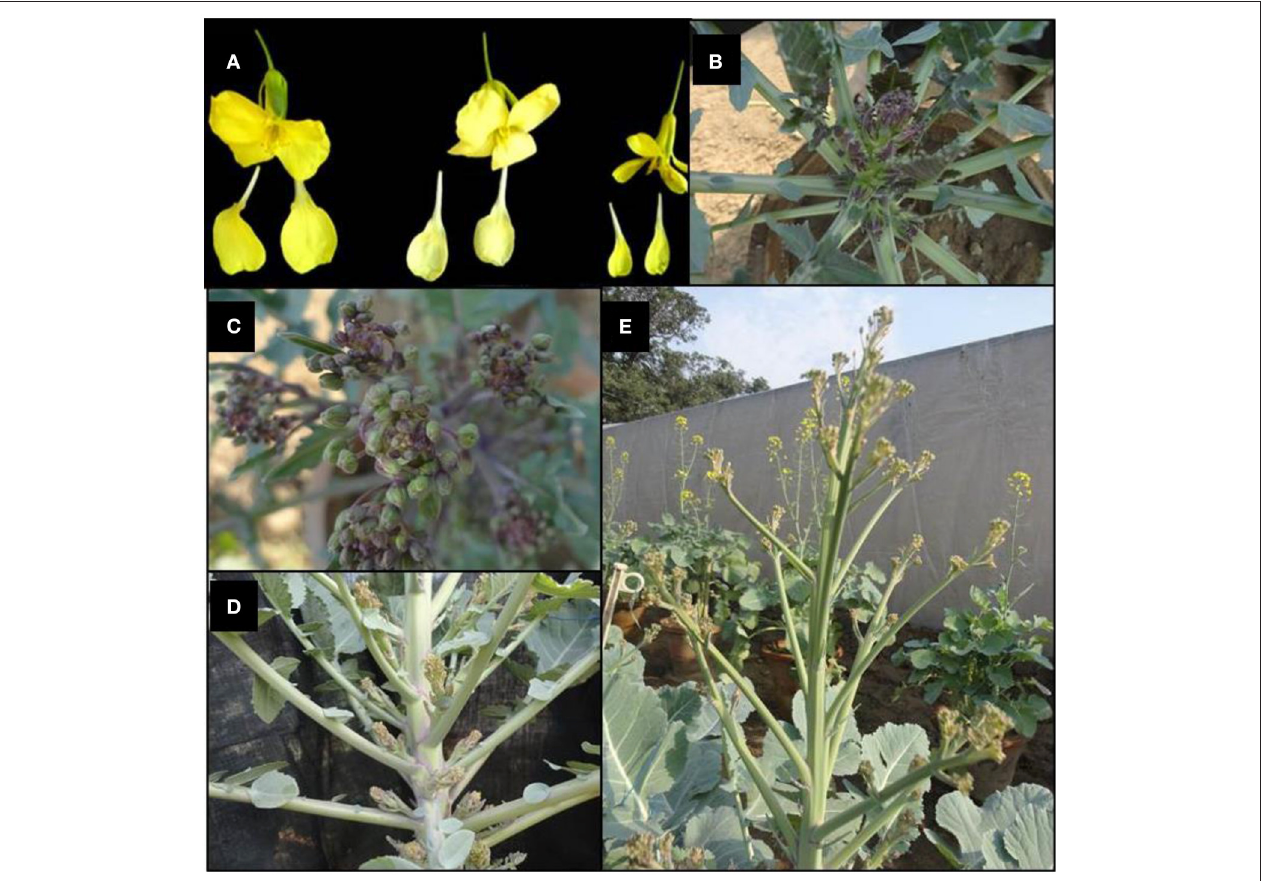
FIGURE 9 | Morphological events of interspecific hybrid and BC 1 progeny. (A) Different size (broad, medium, and narrow) and colors (yellow and cream light yellow) of petals (BC 1 ). (B) Initiation of flower stalk and closer view (C) of inflorescence with purple variegation in interspecific hybrid. (D) Development of many swollen axillary buds prior to elongation of the flowering axis in interspecific hybrid. (E) Branched flowering stalk of an individual of BC 1